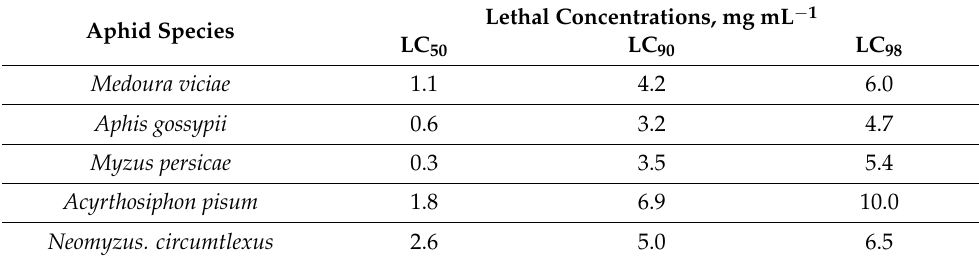
Table 2. Toxicity of the dried ethanol extract (DEE) of Streptomyces sp. P-56 against different aphid species in laboratory experiments in